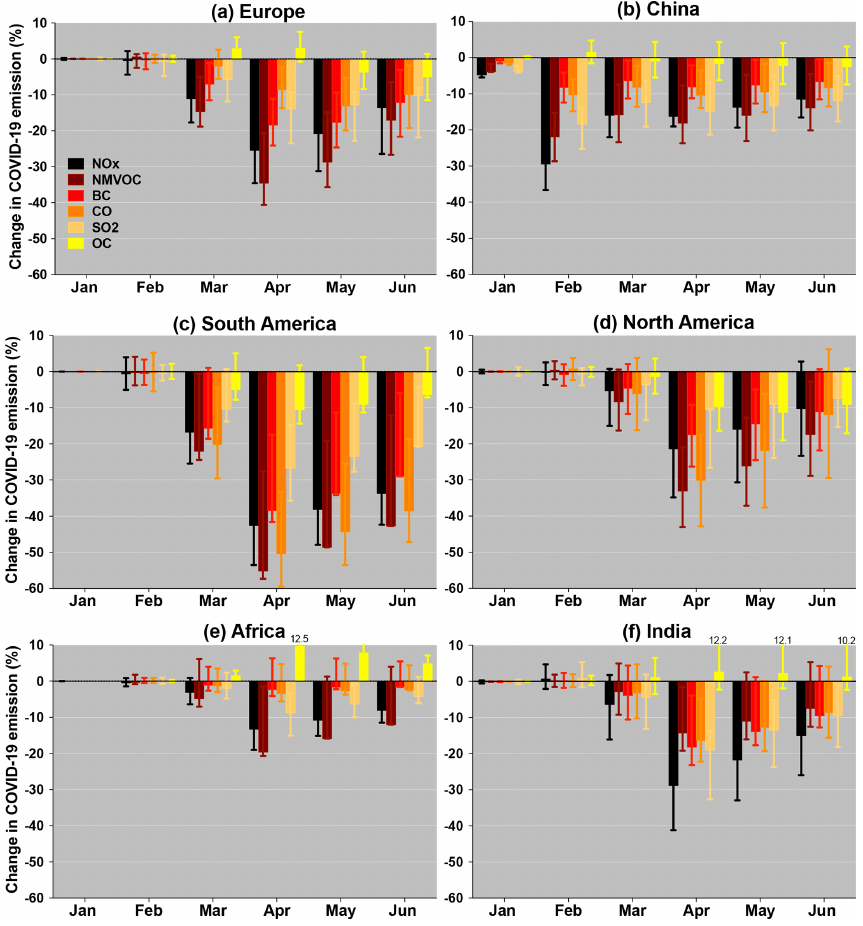
Figure 8. Percentage change in total emissions (combination of emissions from ground transportation, industry, power, residential and shipping) as a function of month for selected regions: (a) Europe (35–70 ◦ N, 20 ◦ W–20 ◦ E), (b) eastern China (20–45 ◦ N, 80–125 ◦ E), (c) South America (60 ◦ S–20 ◦ N, 90–35 ◦ S), (d) North America (20–50 ◦ N, 135–35 ◦ W), (e) Africa (40 ◦ S–30 ◦ N, 20 ◦ W–40 ◦ E) and (f) India (05–30 ◦ N, 60–90 ◦ E). The vertical lines show the uncertainties associated with the estimated regional